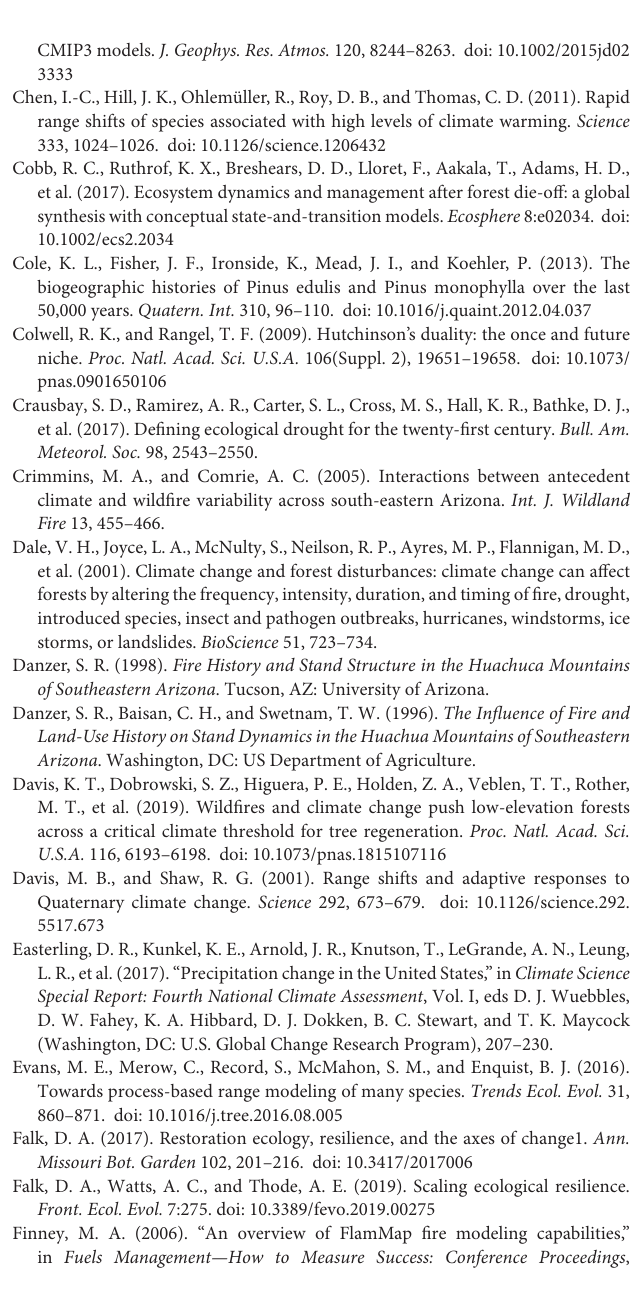
FIGURE S2 | Distribution of dominant vegetation (by biomass) after 50 years of landscape simulation under historical climate with fire. FIGURE S3 | Effects of thinning treatments on fire-caused mortality under historical climate. Maps depict median decadal mortality rate within the study area under scenarios of no thinning (A) , single-entry thinning (B) , and double-entry thinning (C) . Histograms display median and maximum mortality rates within shrubland, woodland, forest, and riparian vegetation zones. TABLE S1 | Effects of climate, fire, and thinning treatments on median basal area (m 2 /ha) within vegetation zones. Scenarios include historical climate with fire and without thinning (Hist No Thin) for reference against climate ensemble projections (Ens) with and without fire and without thinning, single-entry thinning (Thin 1x), and double-entry thinning (Thin